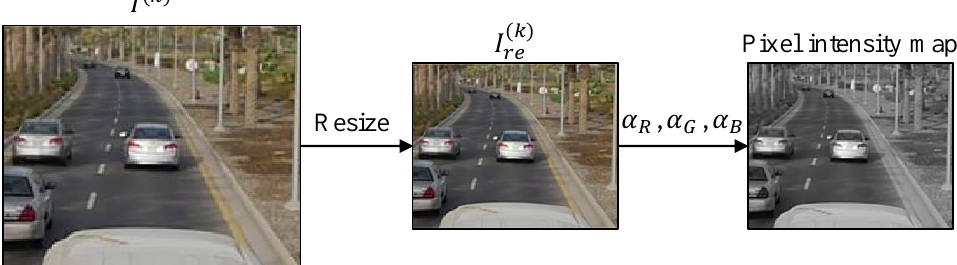
Figure 5. Conversion from I ( k ) to the intensity